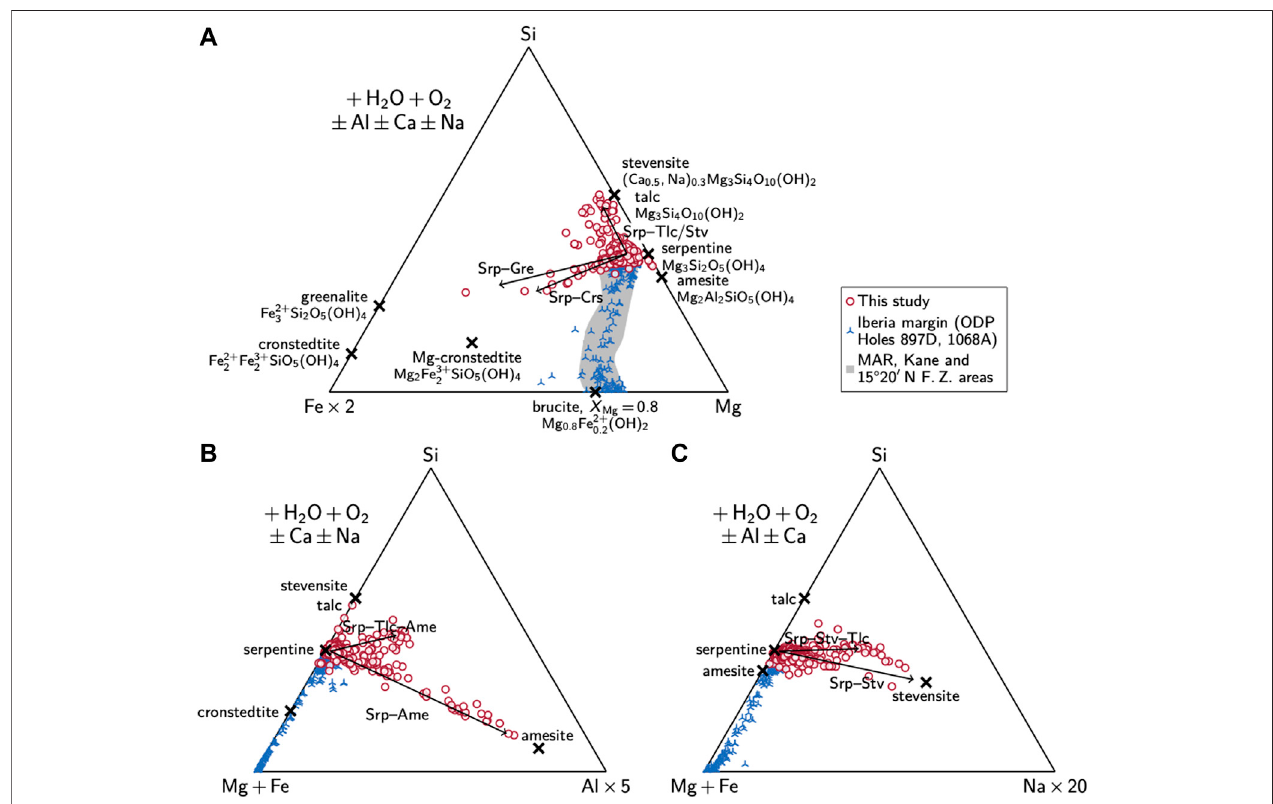
FIGURE5| Si – Fe – Mg – Al – NasystematicsofsecondaryphasesinHole637Asamples (A) Thebulkoftheanalysessuggests high- X Mg serpentine;intergrowth with stevensite and/or talc, serpentine – cronstedtite solid solutions, and mixtures thereof may explain analyses richer in Si and/or Fe. There are no indications of intergrowth with brucite, as is common in ODP Holes 897D and 1068A (Klein et al., 2014) and at the MAR (data from Moll et al., 2007; Klein et al., 2009; Andreani et al., 2013 are shown for comparison) (B) Aluminum contents imply serpentine – amesite mixtures as well as intergrowth of serpentine, amesite, and stevensite/talc (C)